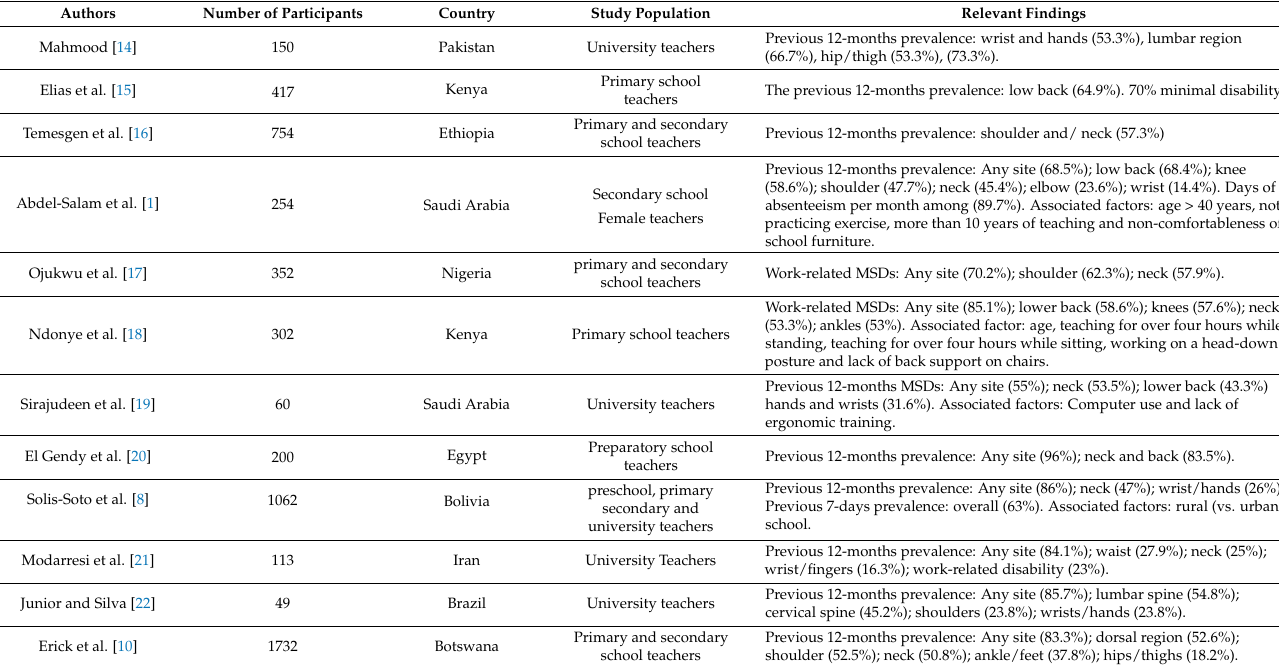
Table 1. Musculoskeletal disorders among teachers in various